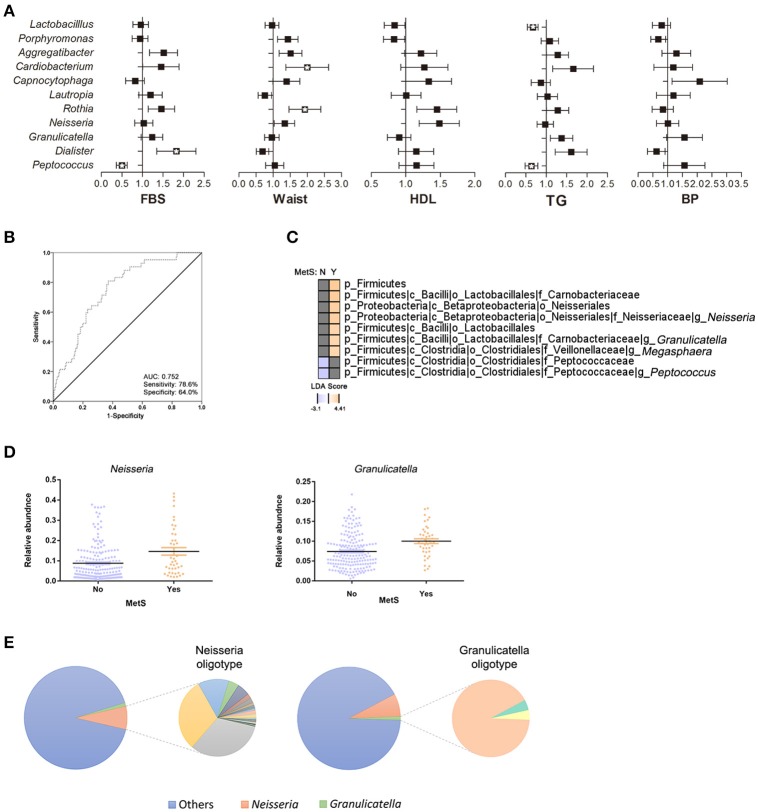
Association of oral bacteria in metabolic syndrome. (A) Odds ratios (ORs) for oral bacteria with risk factors of MetS. Relative abundances of bacteria are adjusted for age, sex, and number of bacteria and are transformed by inverse normalization (*p < 0.05, q < 0.2). (B) Receiver operating characteristic curve for the oral bacteria in ORs (95% confidence interval 0.68 to 0.83; p < 0.001). (C) Comparison of oral microbiota in healthy controls and MetS subjects using LEfSe analysis. (D) Significant changes in oral bacteria were analyzed by multivariate association with linear models after accounting for age, sex, and MetS status. (E) Oligotype distribution of genus Neisseria and Granulicatella in the entire subjects (n = 228): 46 and 3 oligotypes were identified for Neisseria and Granulicatella, respectively.